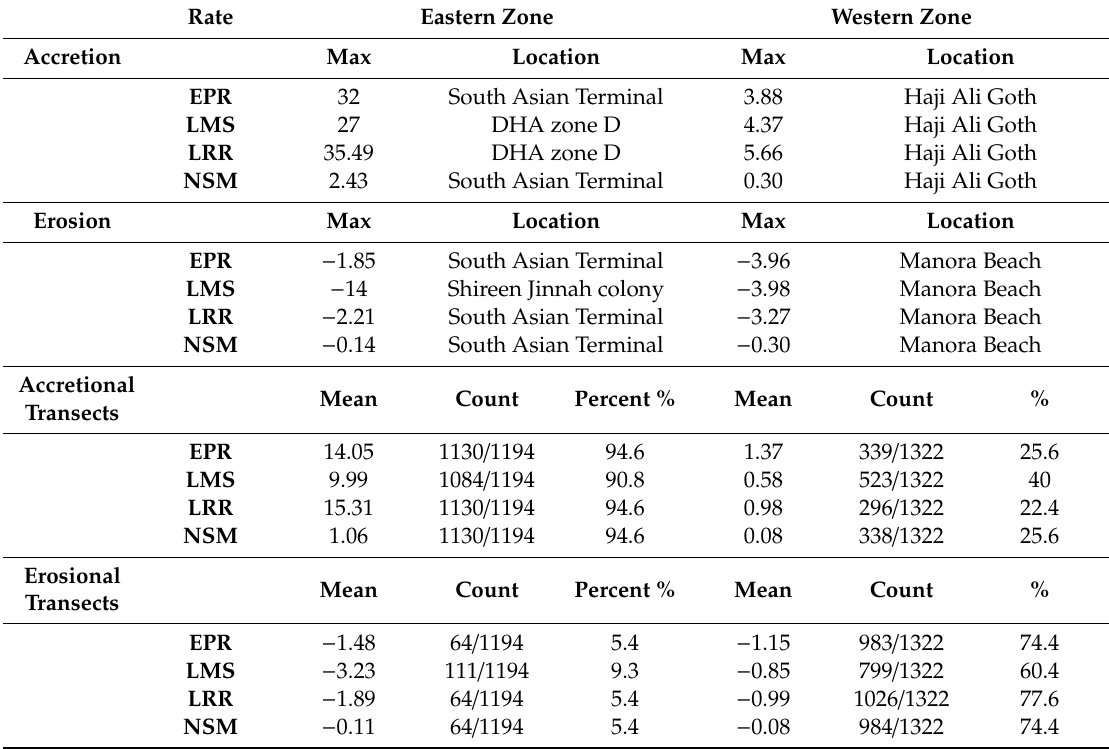
Table 2. Maximum and mean actions (accretion and erosion) at eastern and western zones.